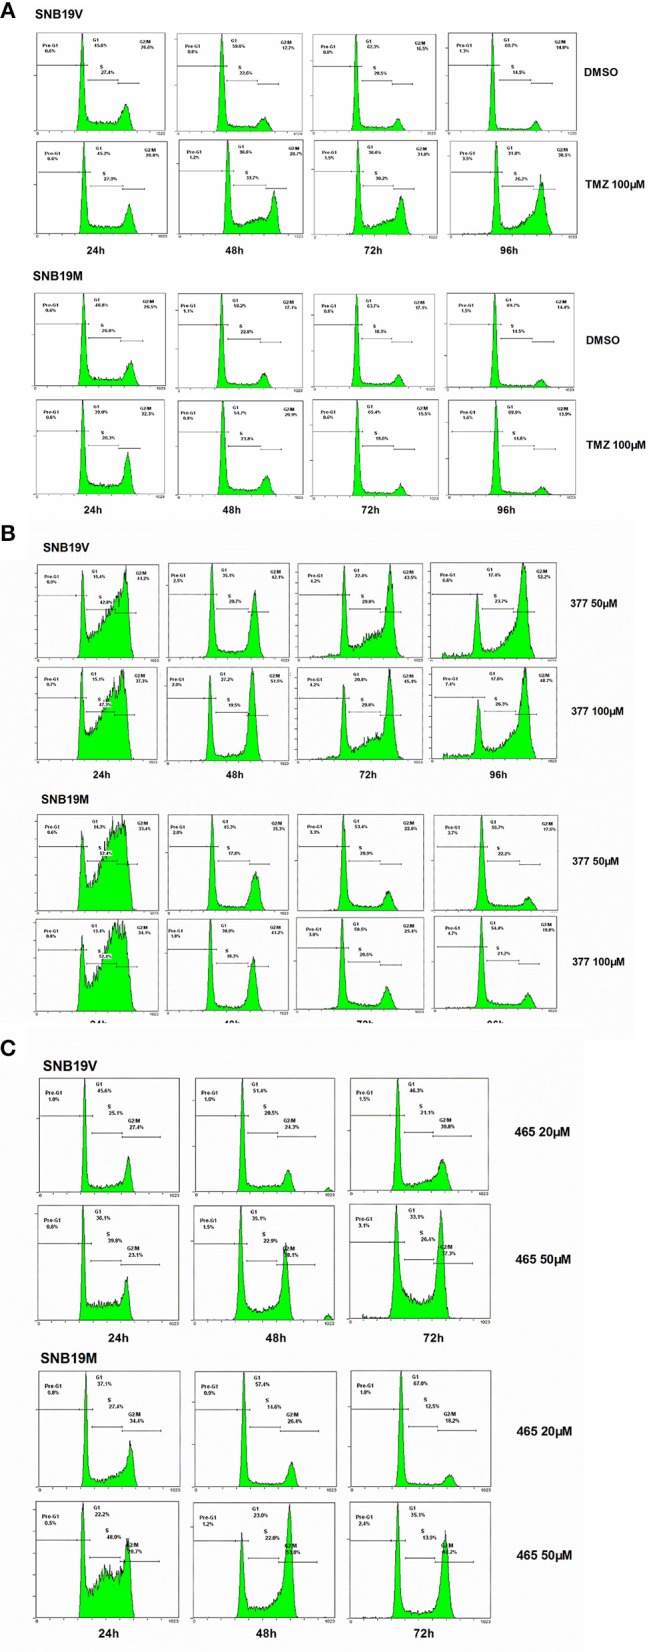
377 and 465 caused cell cycle arrest in SNB19V and SNB19M cells. Representative DNA histograms of SNB19V and SNB19M cells demonstrating the effects of TMZ (A), 377 (B), and 465 (C) on cell cycle progression. Following desired exposure periods, cellular DNA was stained with propidium iodide and analyzed by flow cytometry. Control samples were treated with equal volume DMSO. For each sample, 10,000 events were recorded and experiments were performed in triplicate; n ≥ 3 independent trials.